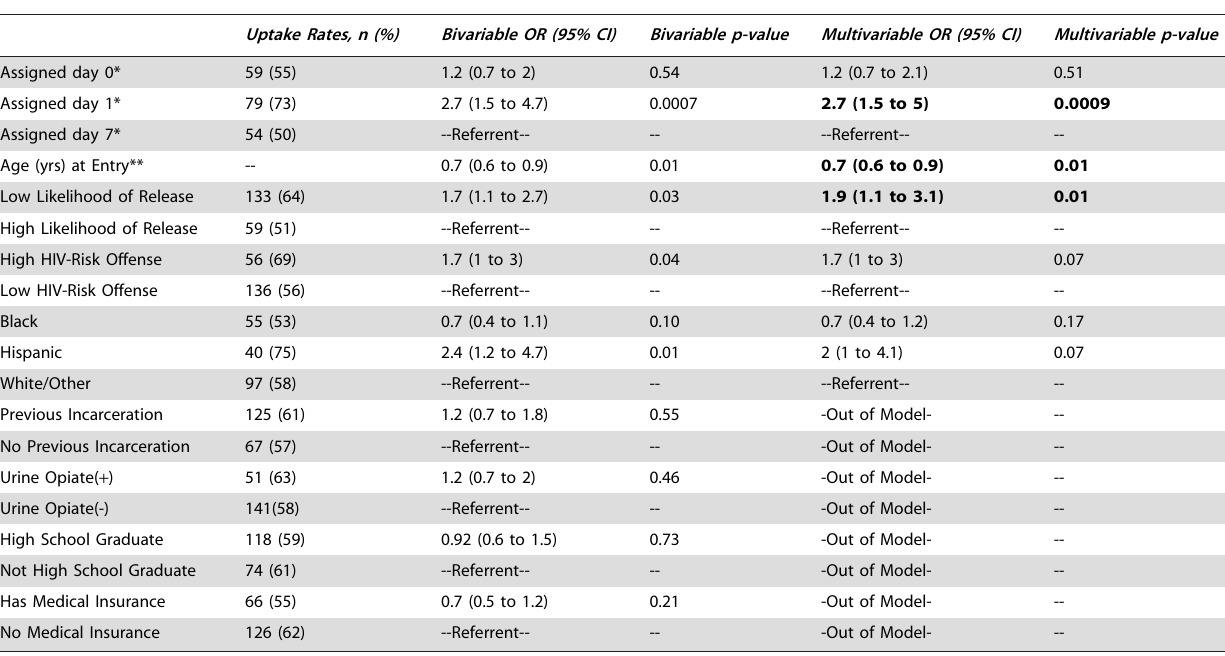
Table 3. Bivariable and Multivariable Predictors of Receipt of